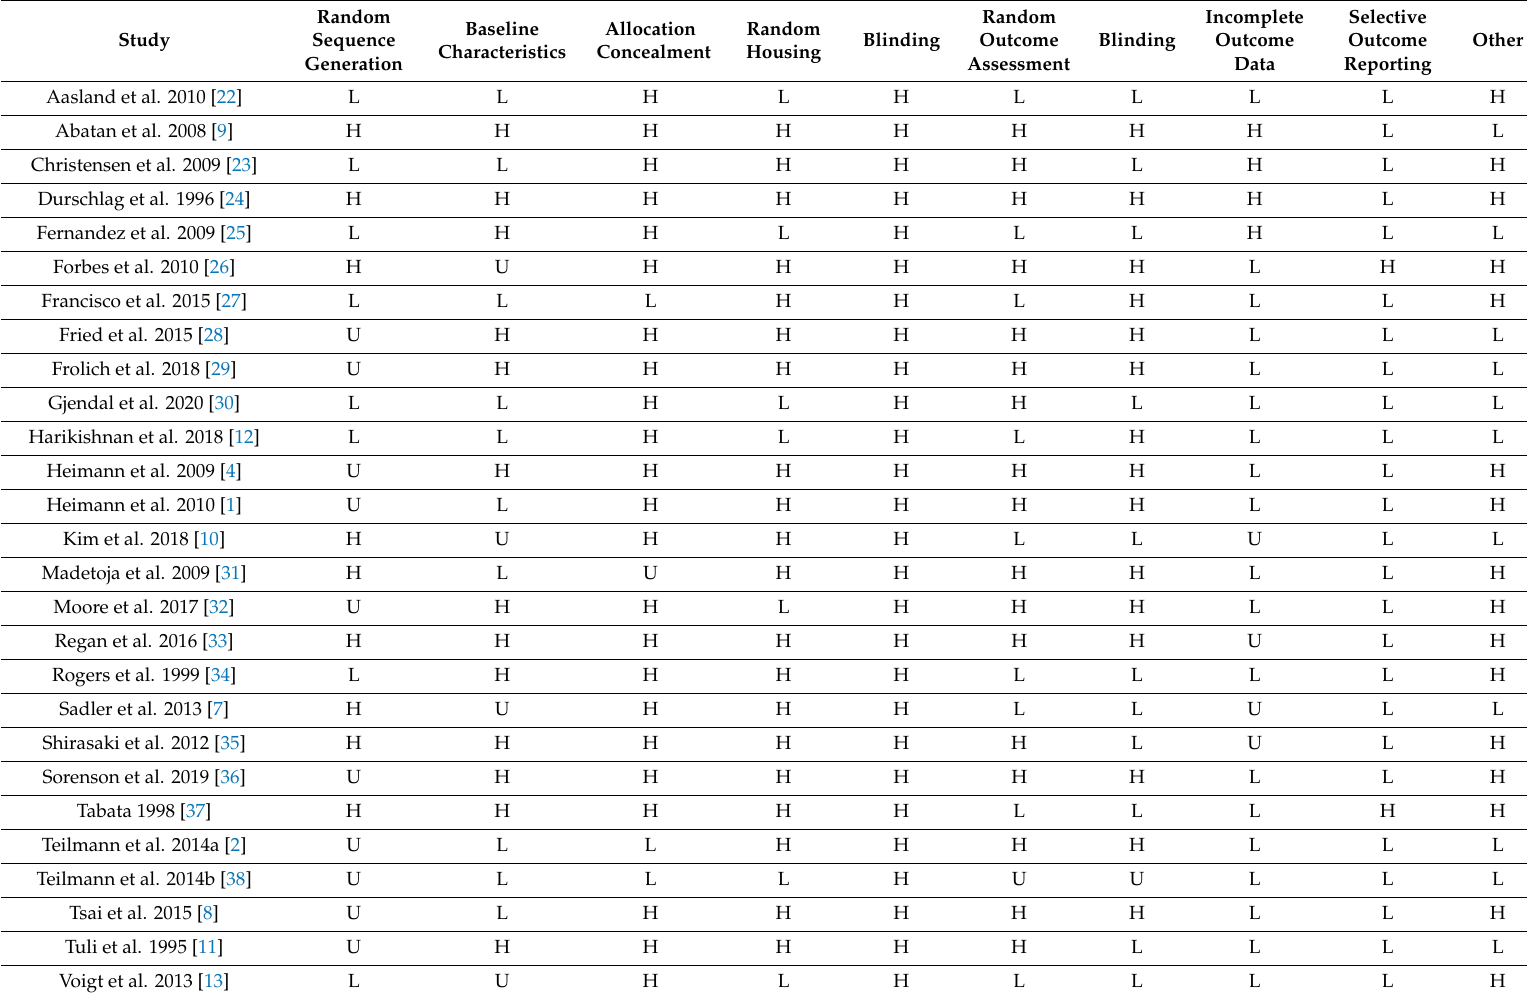
Table 3. Risk of bias assessments for each domain for included studies. L: low risk of bias, U: unclear risk of bias, H: high risk of bias. Study